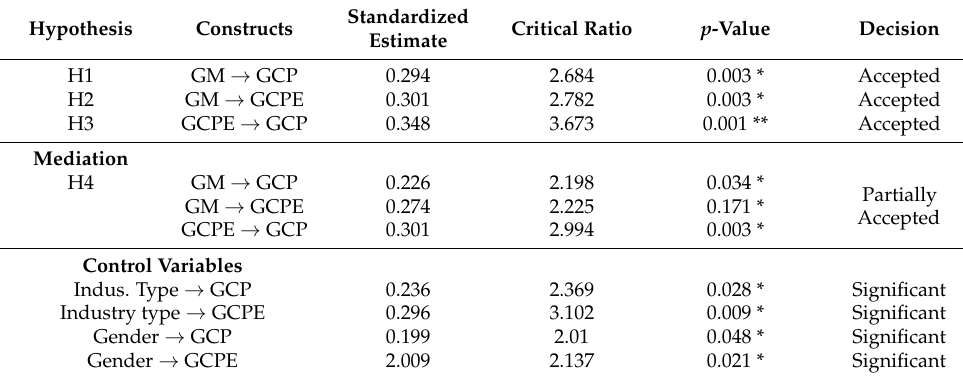
Table 5. Results of hypothesis